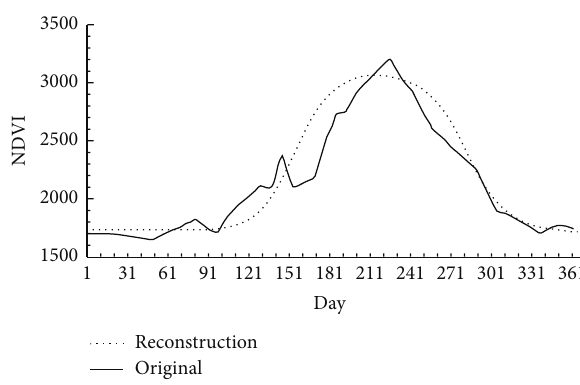
Figure 4: Comparison of original and reconstructed (double- logistic functions) MOD13A2-NDVI time